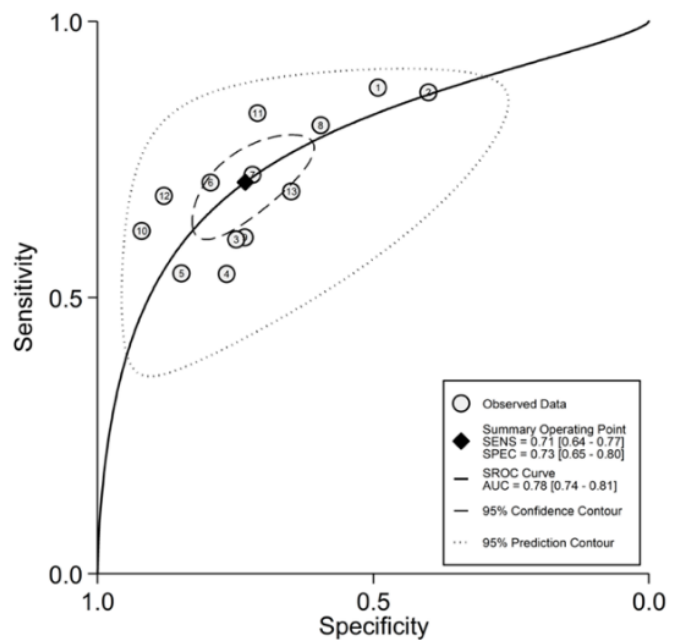
Figure 15. SROC curve with 95% confidence region and prediction region for neutrophil-to- lymphocyte ratio and adverse outcome prediction.